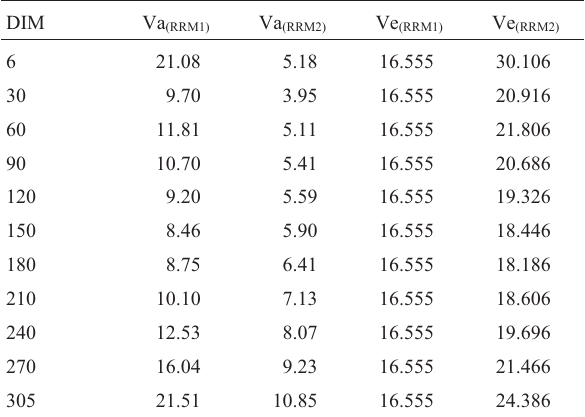
Table 6 - Estimates of genetic and environmental variances for selected DIM of daily yields obtained by the RRM1 and RRM2 models.